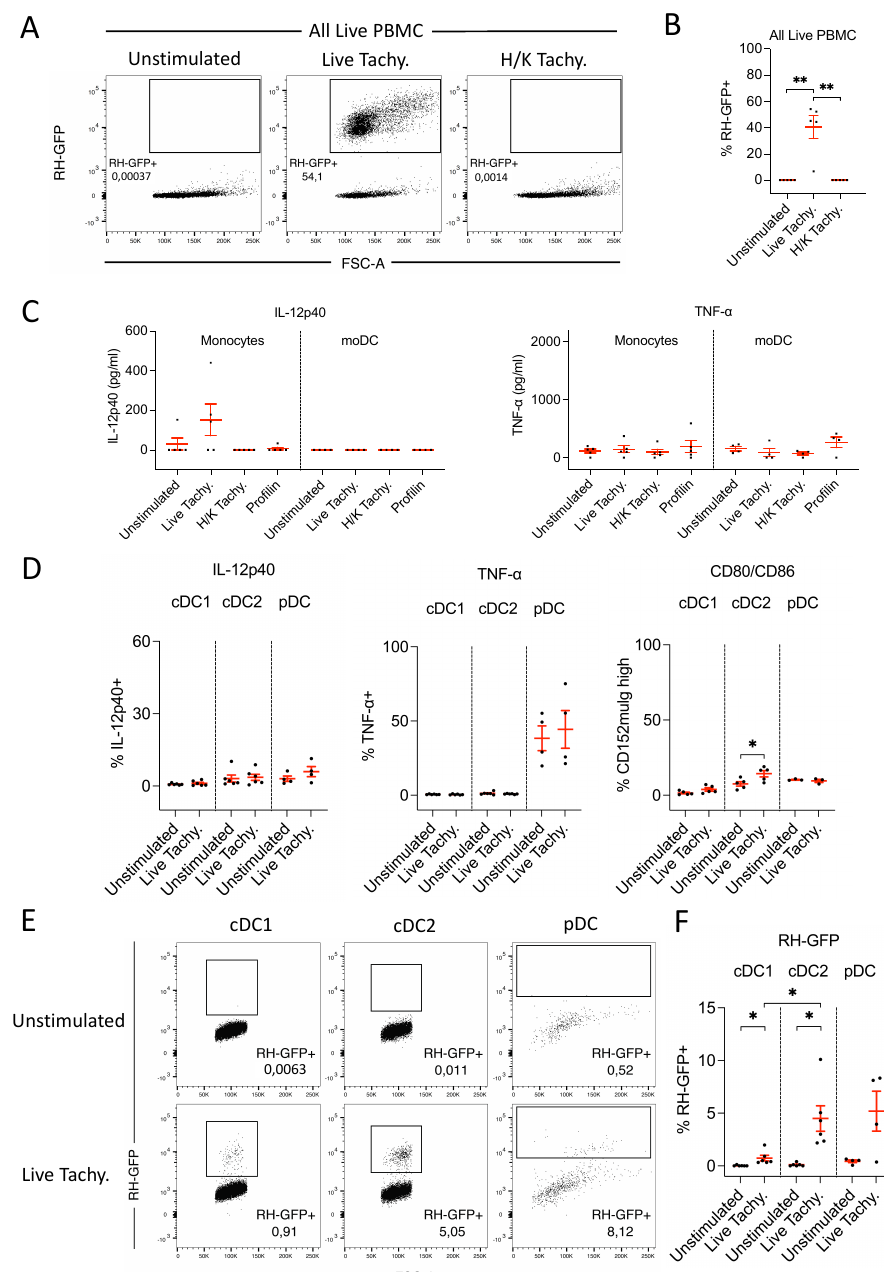
Figure 4. ( A ) Representative plots of GFP+ PBMCs following 24 h incubation with live or heat-killed GFP-labelled T.